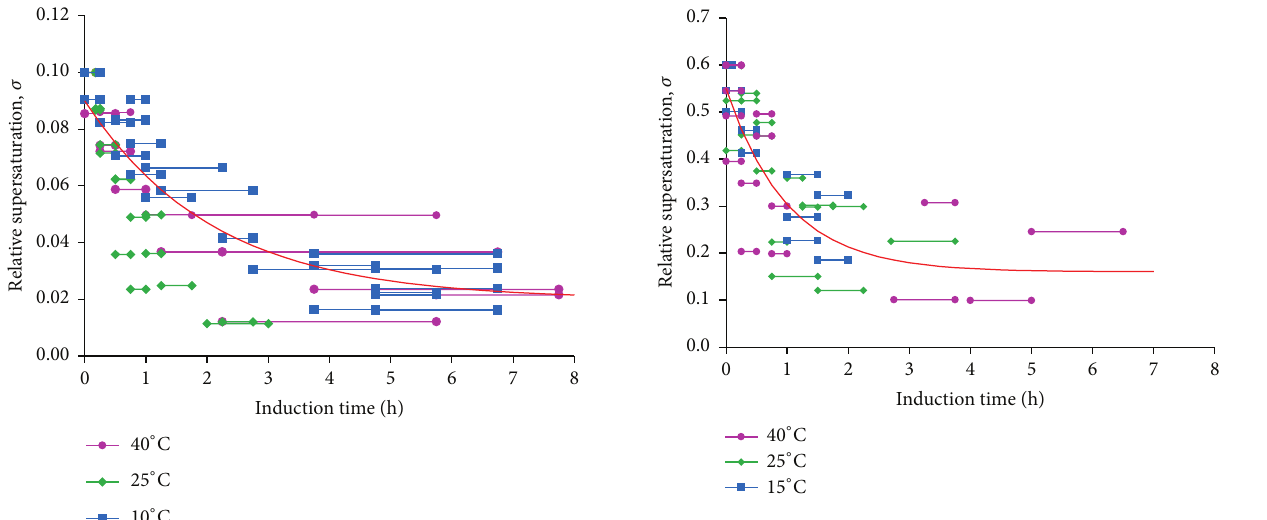
Figure 3: PNT in ethanol at three temperatures. The curve repre- sents the line of fit (2).